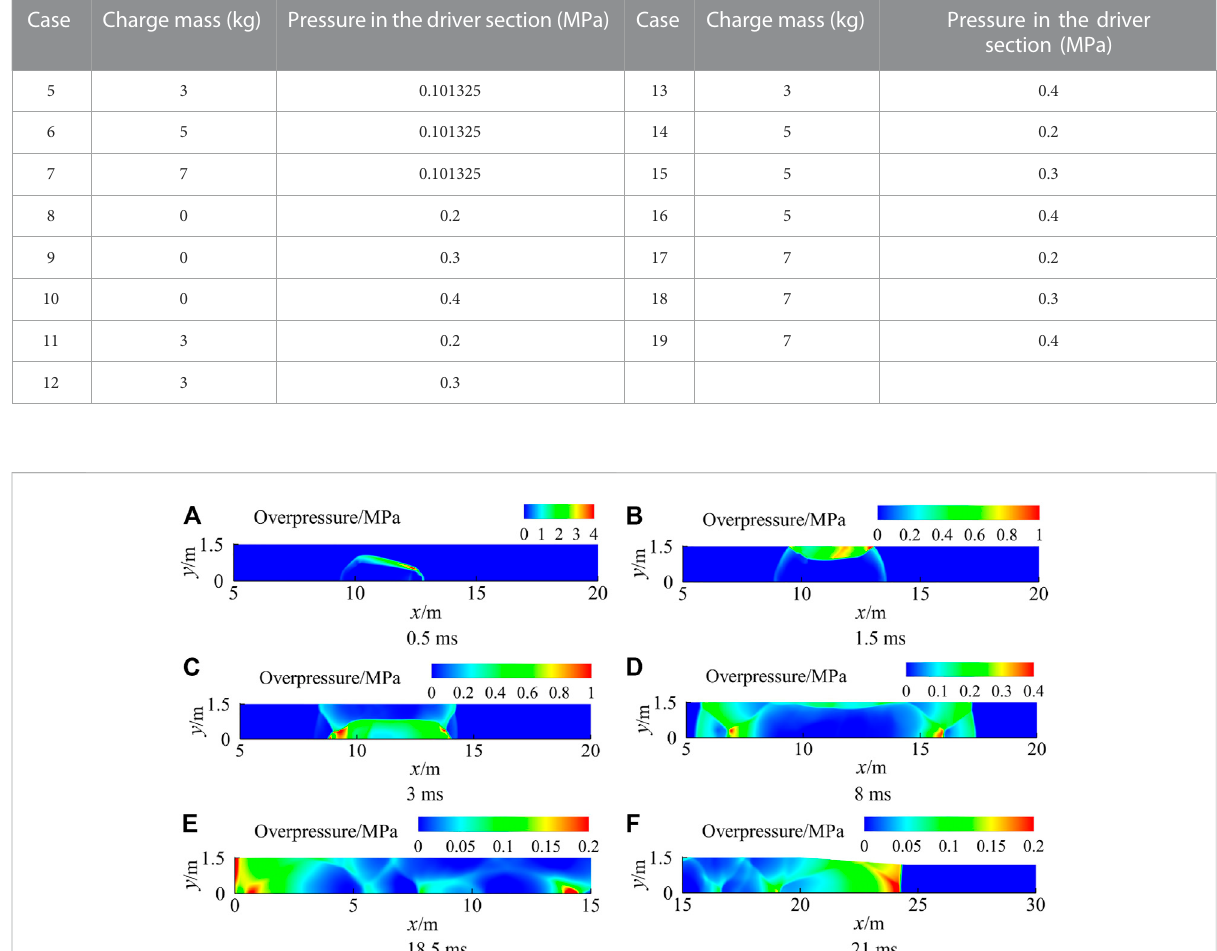
TABLE 3 Initial condition of simulated cases with three drive